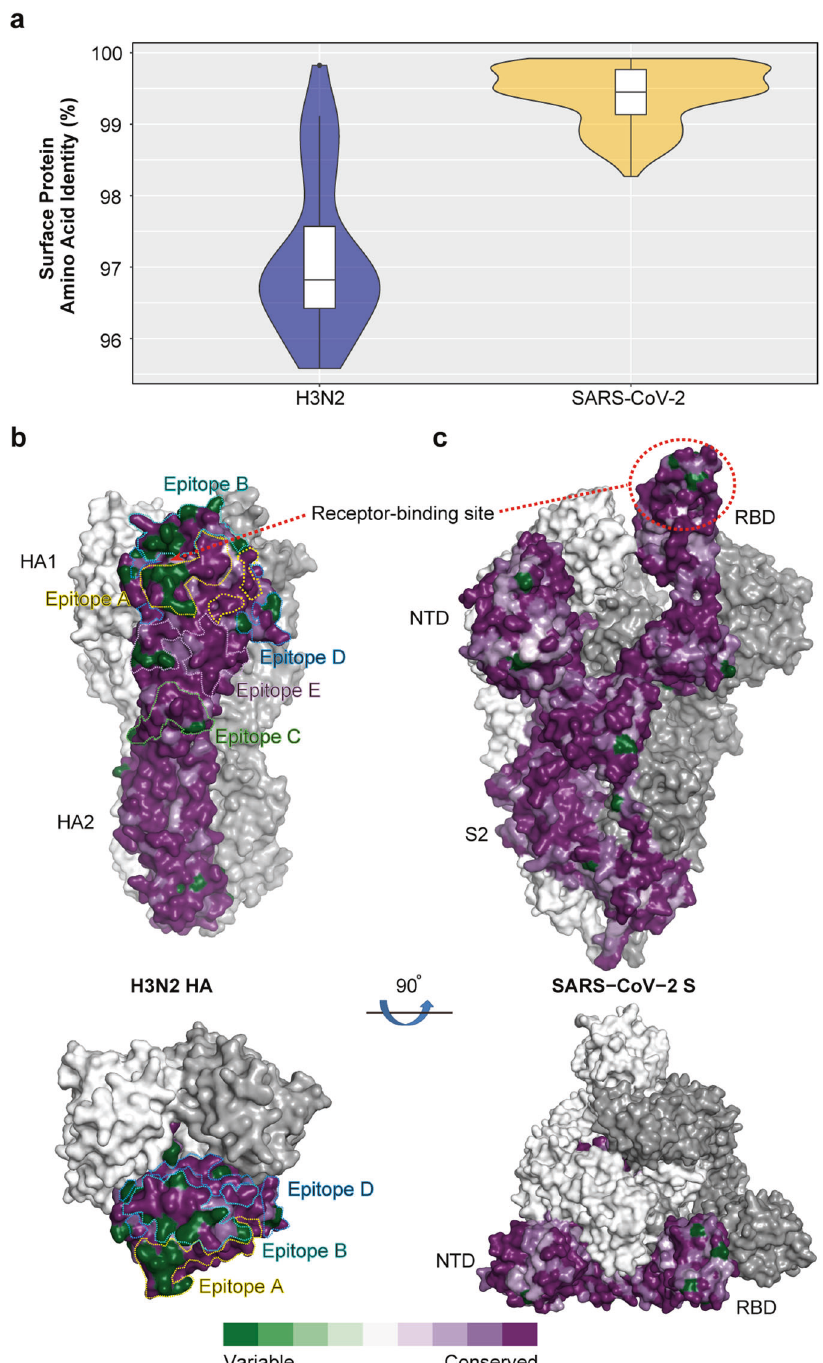
Fig. 6 Antigenic variation analyses of H3N2 HA and SARS-CoV-2 S proteins. a The percent identities of amino acid sequences of representative H3N2 HA and SARS-CoV-2 S protein are shown respectively. b The surface view of an H3N2 HA trimer (A/Victoria/361/2011; PDB code: 4O5N) is shown. One monomer of the HA surface is colored using the ConSurf server 34 according to sequence conservation from the most conserved (dark purple) to the most divergent (dark green) based on the alignment of H3N2 sequences from different vaccine strains. The fi ve antigenic sites A (yellow), B (cyan), C (green), D (blue) and E (pink) are highlighted in dotted circles. c The surface view of the SARS- CoV-2 D614G S protein trimer (PDB code: 7KE9) is shown. One monomer of the S surface is colored using the ConSurf server 34 according to sequence conservation from the most conserved (dark purple) to the most divergent (dark green) based on the alignment of S sequences from different VOC strains. The receptor-binding sites are highlighted in dotted circles. HA haemagglutinin, H3N2 haemagglutinin 3 neuraminidase 2, SARS-CoV-2 severe acute respiratory syndrome coronavirus 2, S spike, PDB protein data bank, VOC variant of concern